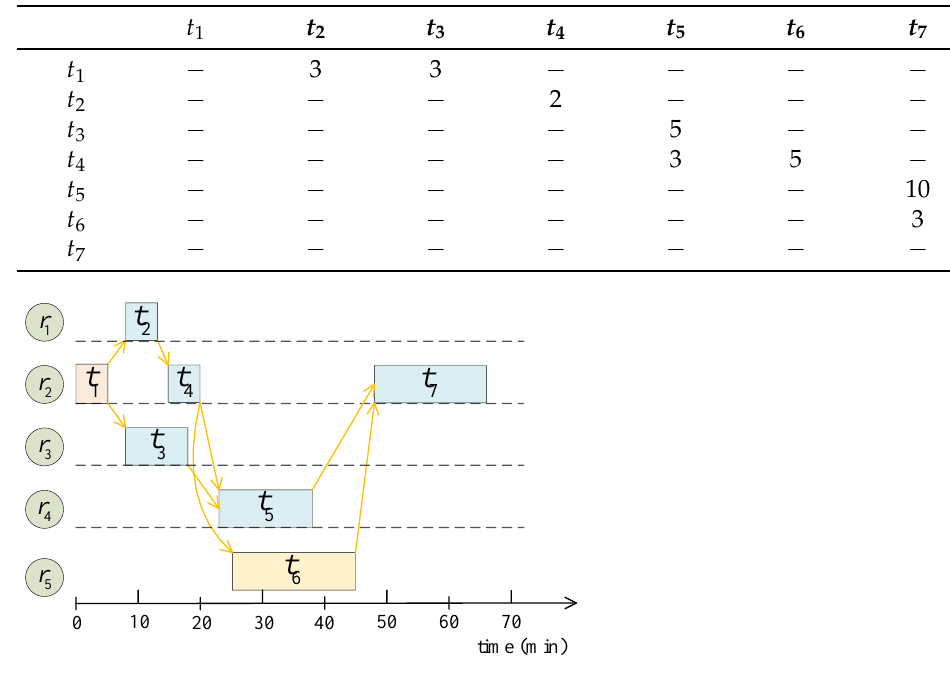
Figure 2. Example of a schedule. Table 3. Start time st ( · ) and finish time ft ( · ) (in minute) of each workflow